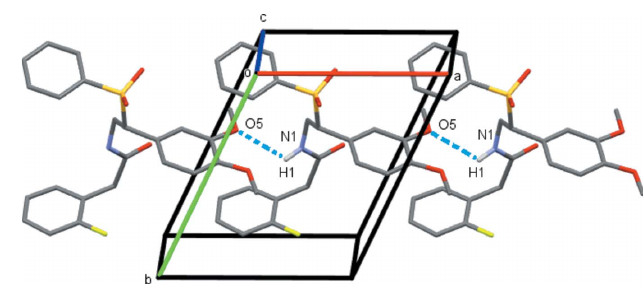
Figure 3 Crystal packing of the title compound viewed along the c axis. Intermolecular hydrogen bonds are shown as dashed blue lines. Hydrogen atoms not involved in hydrogen bonding are omitted for clarity.